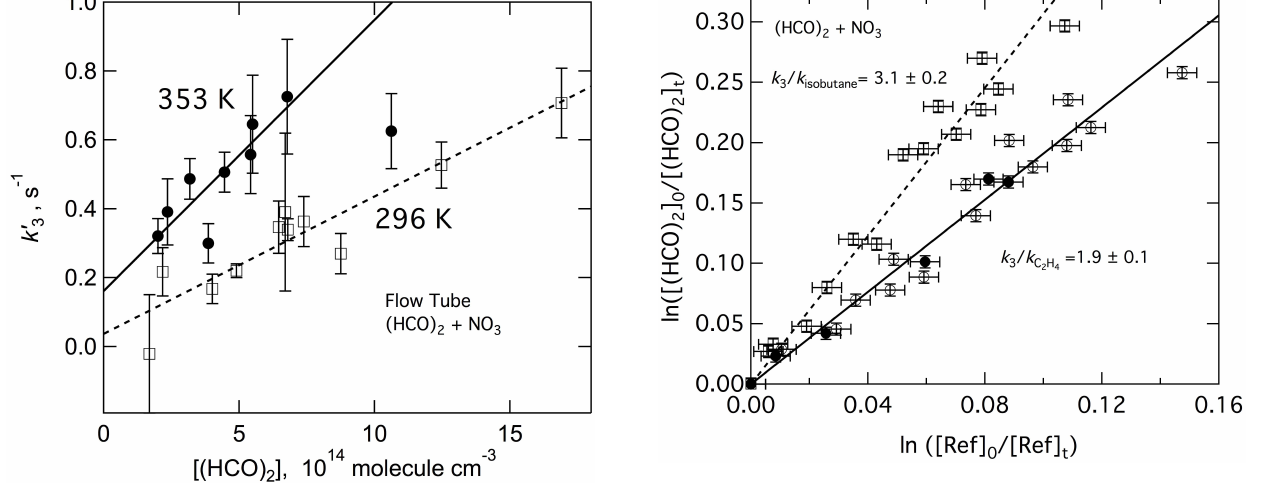
Fig. 5. Pseudo-first-order rate coefficients for the reaction of NO 3 + (HCO) 2 (glyoxal) obtained at 296 and 353K using a fast flow- reactor with chemical ionization mass spectrometer (CIMS) detec- tion of NO 3 .